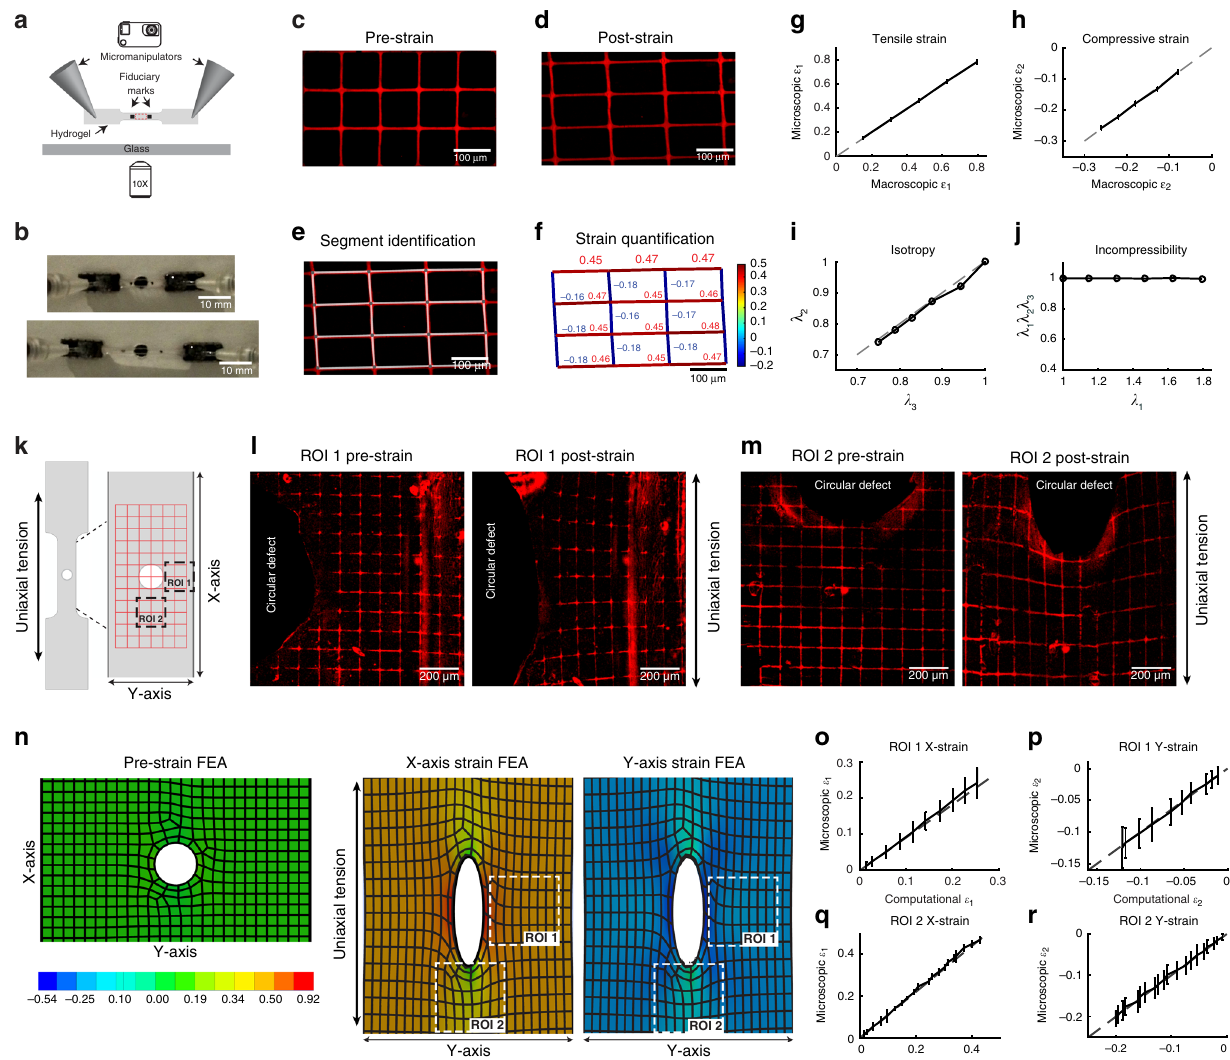
Fig. 2 Uniaxial tensile testing and fi nite element analysis of the nanomechanical biosensor (NMBS) on a polydimethylsiloxane (PDMS) test strip. a A PDMS dog bone test strip with applied NMBS is mounted on micromanipulators attached to a wide- fi eld fl uorescence microscope to view the NMBS (100 µ m × 100 µ m × 10 µ m) from underneath while tracking fi ducial marks on the top surface during uniaxial tensile testing. b Example images of the PDMS test strip in the pre-strain and post-strain states. c Representative fl uorescence image of pre-strained NMBS prior to tensile testing. d Representative fl uorescence image of deformed NMBS following tensile testing. e Image segmentation and analysis is performed to identify rectangular mesh NMBS nodes and segments are then overlaid onto the deformed image. f Segment lengths are converted into tensile (positive) and compressive (negative) mechanical strains with respect to their pre-strain reference length. A color map reveals locations of tensile (red) and compressive (blue) mechanical strains. g The microscopic tensile strain ε 1 of the NMBS strongly correlates with the macroscopic tensile strain ε 1 of PDMS (mean± S.D.; n = 12 segments over 1 experiment). h The microscopic compressive strain ε 2 of the NMBS strongly correlates with the macroscopic compressive strain ε 2 of PDMS (mean ± S.D.; n = 12 segments over 1 experiment). i There is a strong correlation between the stretch ratios λ 2 and λ 3 con fi rming that PDMS is an isotropic material. j The product of the stretch ratios λ 1 λ 2 λ 3 is equal to 1 con fi rming that PDMS is incompressible. k A circular defect in the PDMS test strip was introduced to track heterogeneous strain fi elds with the NMBS during uniaxial tensile testing. l Representative fl uorescence images from ROI 1 (region adjacent to the circular defect and antiparallel to the uniaxial tension) of the NMBS pre and post tensioning. m Representative fl uorescence images from ROI 2 (region adjacent to the circular defect and parallel to the uniaxial tension) of the NMBS pre and post tensioning. n Finite element analysis of a PDMS test strip with a circular defect in the pre-strain, X-strain, and Y-strain states following 40% uniaxial strain (blue = compression; green = no strain; red = tension). o Quantitative analysis of ROI 1 reveals a strong correlation between the microscopic X-strain ε 1 of the NMBS with the computational tensile X-strain ε 1 (mean ± S.D.; n = 28 segments over 1 experiment). p Additionally, there is a strong correlation between the microscopic Y-strain ε 2 of the NMBS with the computational compressive Y-strain ε 2 (mean ± S.D.; n = 30 segments over 1 experiment). q Quantitative analysis of ROI 2 reveals a strong correlation between the microscopic X-strain ε 1 of the NMBS with the computational tensile X-strain ε 1 (mean ± S.D.; n = 8 segments over 1 experiment). r Additionally, there is a strong correlation between the microscopic Y-strain ε 2 of the NMBS with the computational compressive Y-strain ε 2 (mean ± S.D.; n = 9 segments over 1